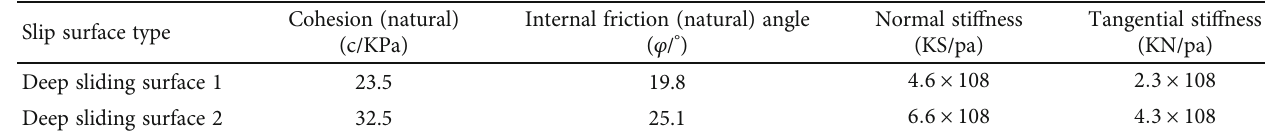
Table 3: Parameter value of sliding